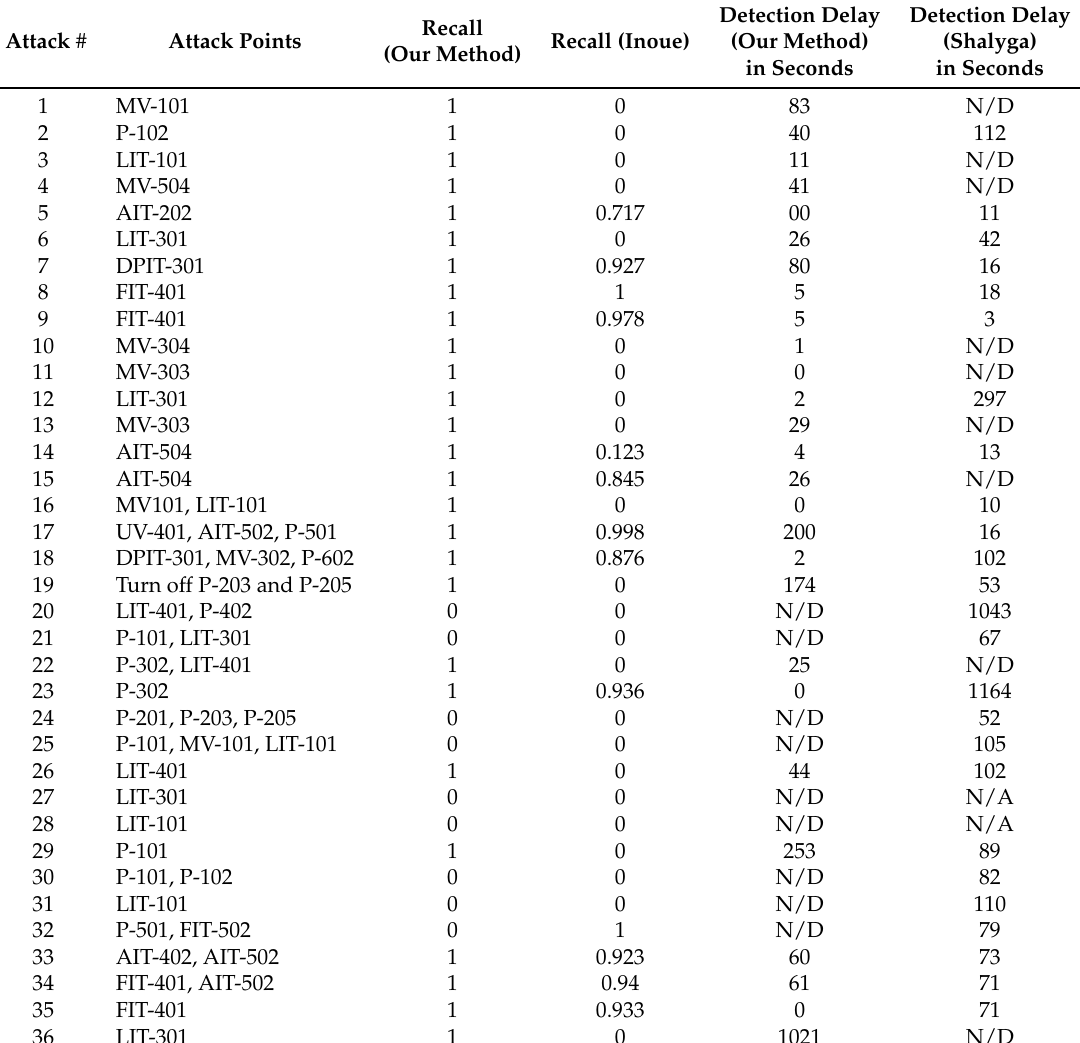
Recall rates and detection delay for each attack is compared to baseline formed in Inoue et al. [15] and Shalyga et al. [16] Detection Delays of N/D mean attacks were not detected, while N/A signifies unavailability of time in baseline